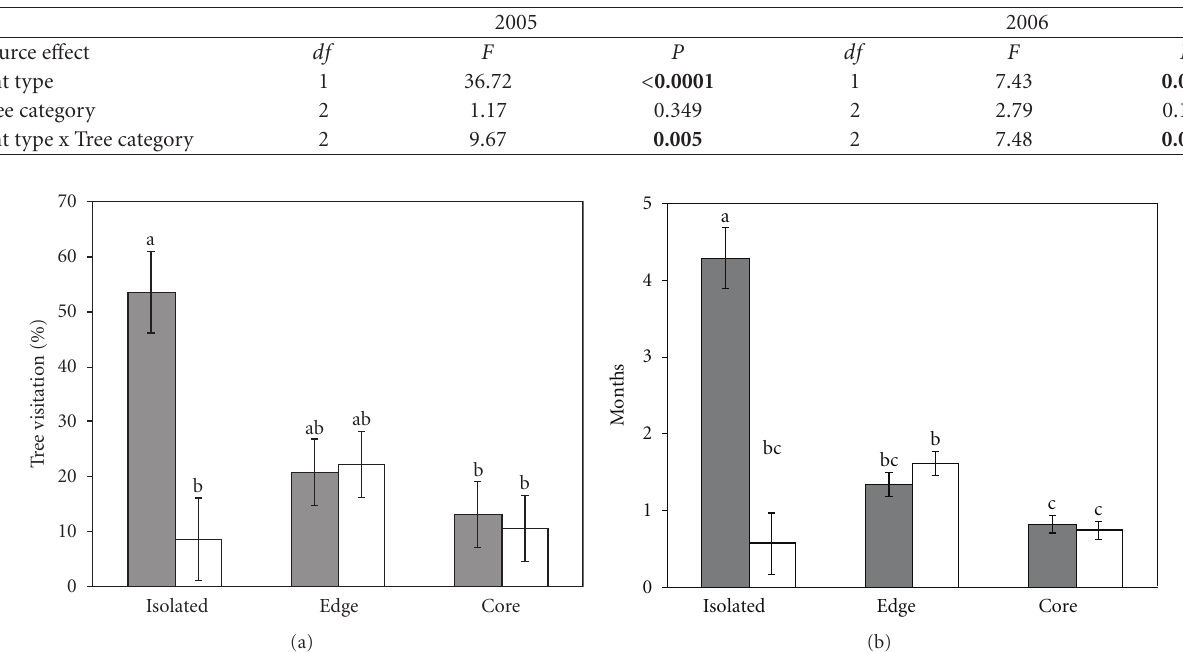
Table 3: Repeated measures ANOVA of tree visitation (%) at invaded fragments, depending on ant type (invasive or native) and tree category (isolated, edge or core trees). Significant e ff ects ( P < 0 . 05) are shown in bold.